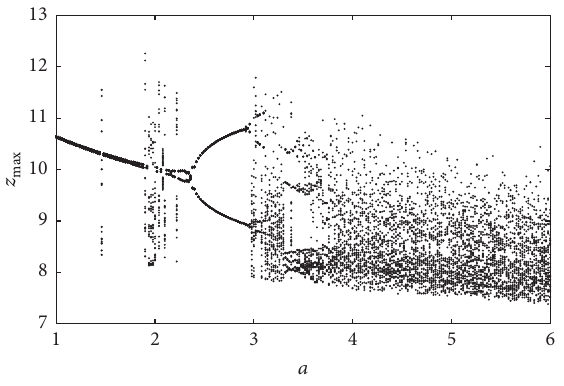
Figure 5: Bifurcation diagram of 𝑧 𝑚𝑎𝑥 with 𝑏 = 0.001 and 𝑎 as varying